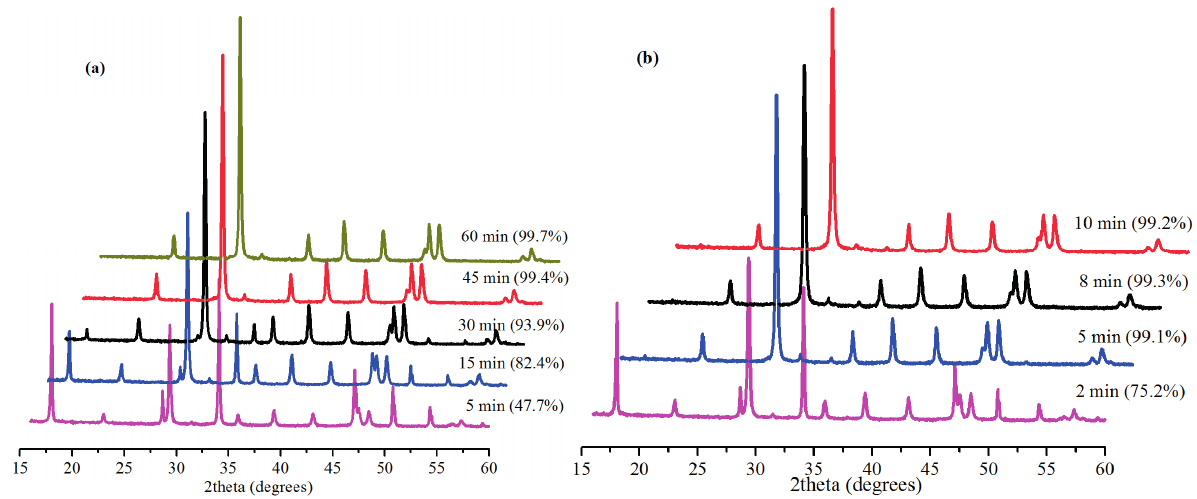
Figure 5. XRD patterns and corresponding conversions (in brackets) for samples produced with Bmim[Br] with different reaction times at ( a ) 0.1 MPa and ( b ) 5.0